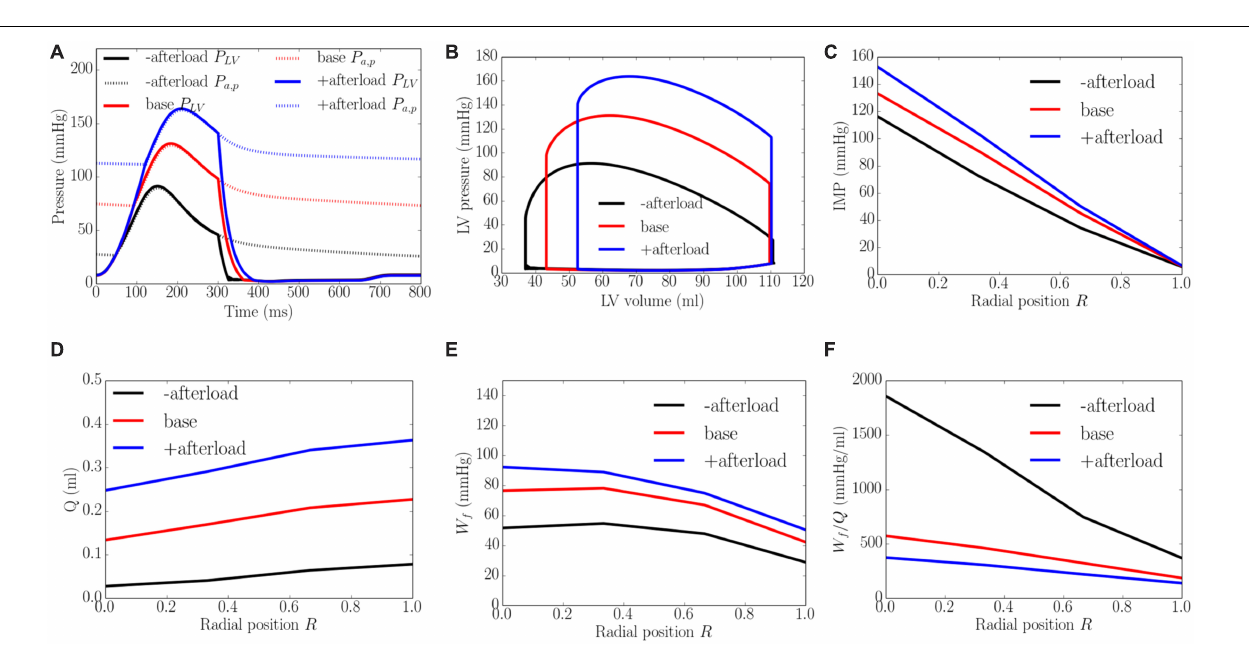
FIGURE 5 | Effects of myocardial contractility on (A) Pressure waveforms; (B) LV pressure-volume loop; Transmural distribution of (C) IMP; (D) Total coronary flow over a cardiac cycle; (E) Work density over a cardiac cycle W f ; (F) Work density-perfusion mismatch index ratio W f / Q . “- T max ,” “base,” and “+ T max (cid:48)(cid:48) denote T max = 65, 130, and 205 kPa.